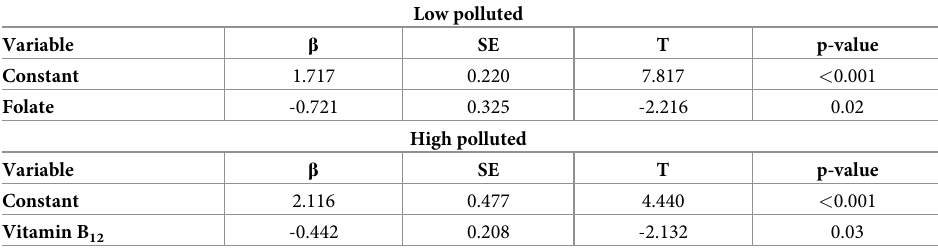
Table 4. Stepwise backward linear regression analysis for the effect of independent variables on global methyla- tion in low and high polluted